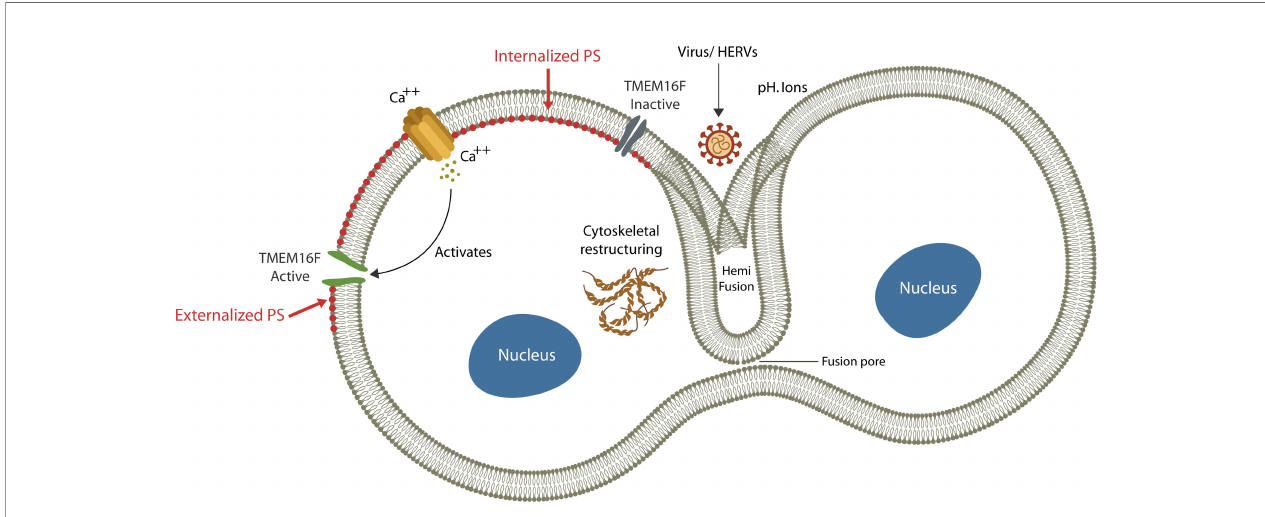
FIGURE 1 | Exogenous viruses and HERVs can hijack physiological fusogens, fusing host cells. The fusion process is comprised of: (1) cytosolic Ca2+ upregulation ( via extracellular compartment uptake or endoplasmic reticulum release), (2) TMEM16F activation and (3) PS externalization (ePS). Cells undergo fusion or elimination, depending on extracellular pH. Viruses bene fi t from ePS and elevated cytosolic Ca2+ as the former induces immunosuppression and the later cellular